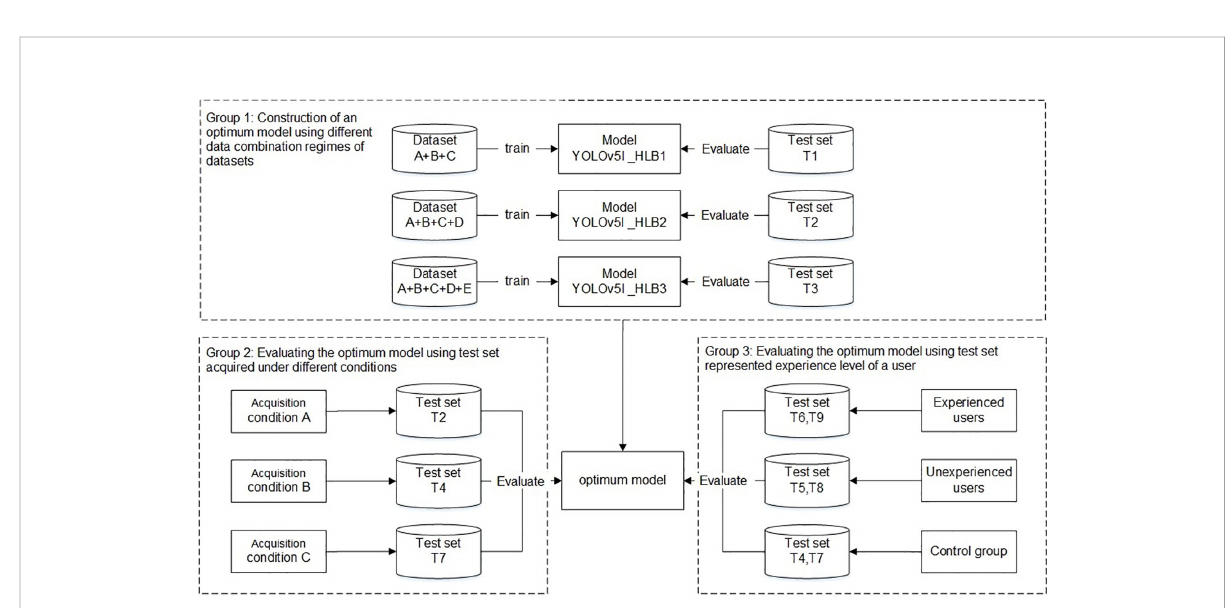
FIGURE 4 Work fl ow used to develop and evaluate a HLB-detection model based on the YOLO (You Only Look Once) image-detection